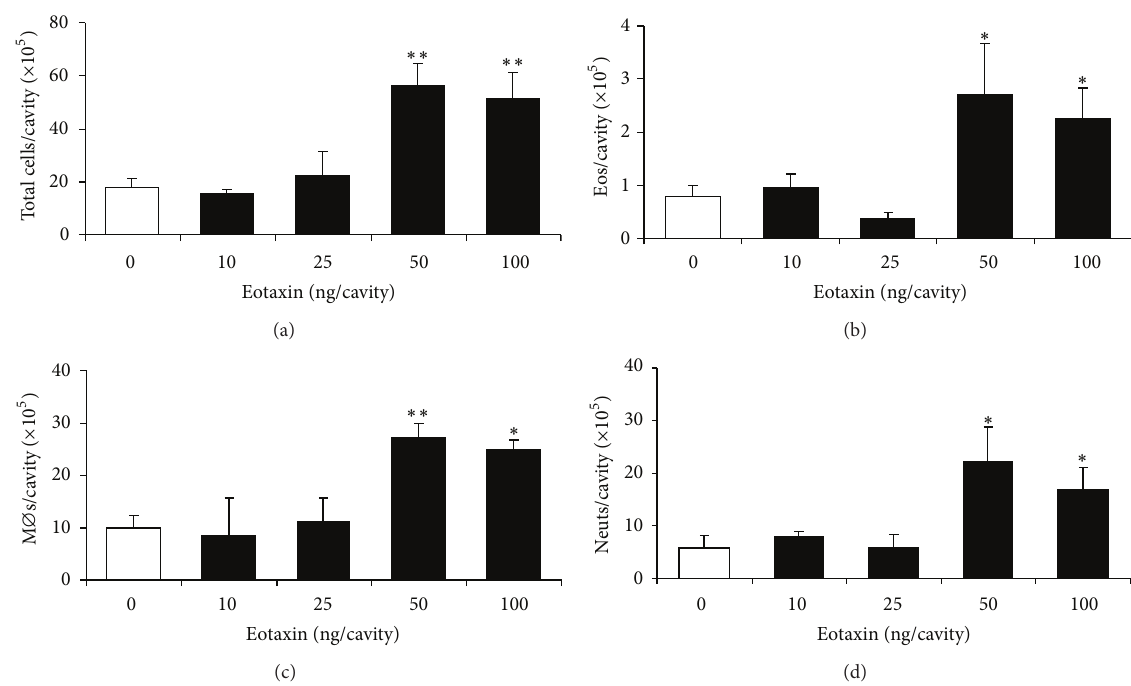
Figure 1: Accumulation of different leukocyte subtypes induced by eotaxin in naive mice: dose-response relationship . BALB/c mice were injected with the indicated doses of eotaxin (black bars), and the peritoneal lavage fluid collected 4 h later was used for quantitation of total leukocytes (a), eosinophils (b), macrophages (c), and neutrophils (d). Data are mean ± SEM. ∗ , 𝑃 ≤ 0, 05 ; ∗∗ , 𝑃 ≤ 0, 01 , for the differences relative to the negative (RPMI) control (0ng/mL eotaxin, open bars). (a) Data from 3–18 experiments. (b)–(d) Data from 6–11 experiments.